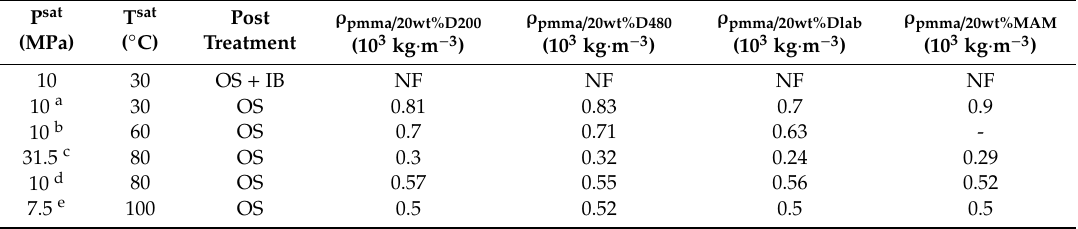
Table 4. Set of experiments II: Density variations observed in various batch foaming conditions (P sat , T sat ).